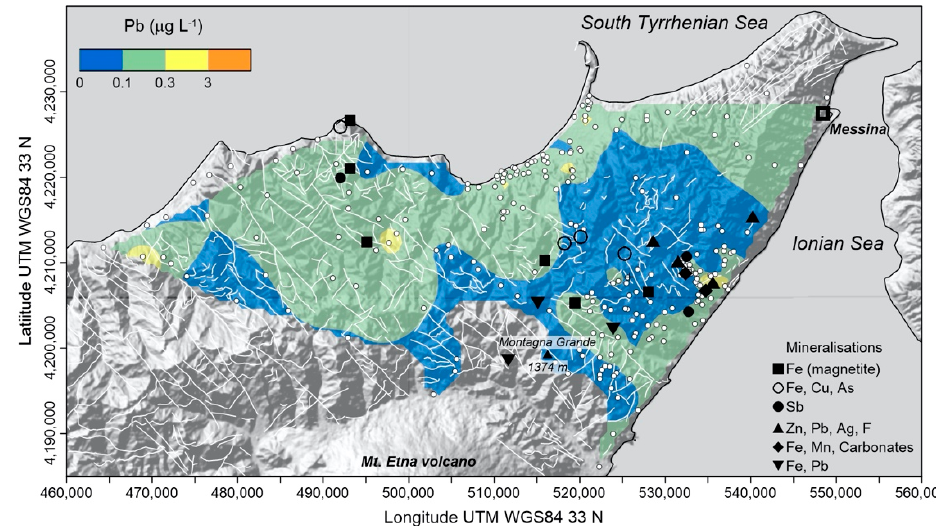
Figure 9. Concentration distribution map of Pb, reporting locations of sampling points (with indication of those exceeding the related MACs) and main mineral deposits; tectonic lineaments (white lines) are also illustrated.